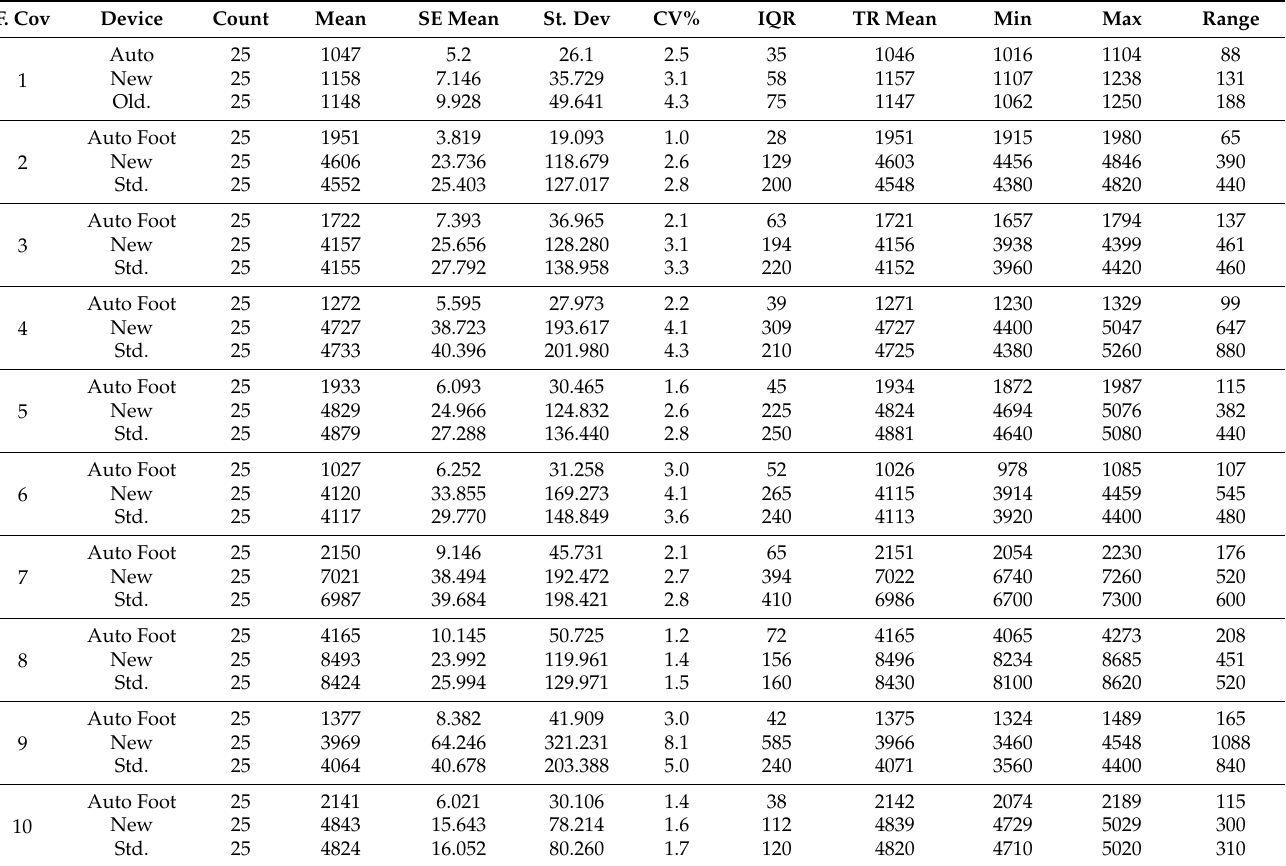
Table 4. Descriptive statistics of floorcoverings samples for highest peaks checked on old, new, and automated